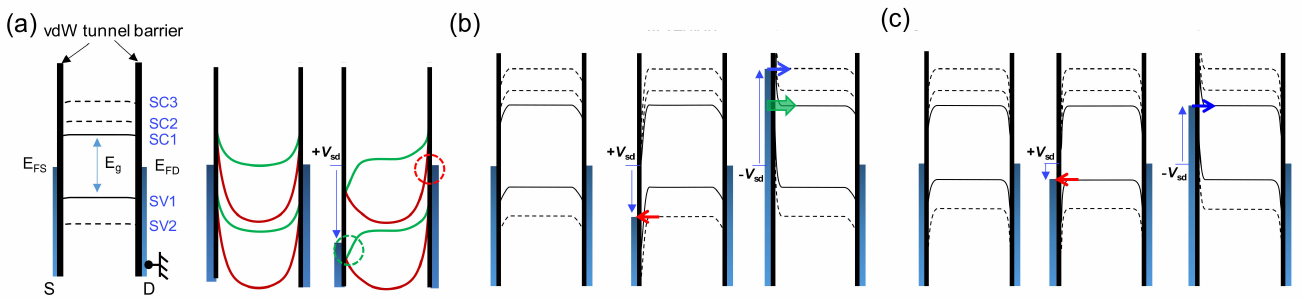
Figure 3. ( a ) Left: electronics bands for V bg = 7 V, middle and right: electronic bands for 7 V < V bg < 20 V (green curves) and V bg > 20 V (red curves). SC n (SV n ) is the n th subband in the conduction (valence) band. Electronic bands for ( b ) − 20 V < V bg < − 17 V and ( c ) V bg < − 22